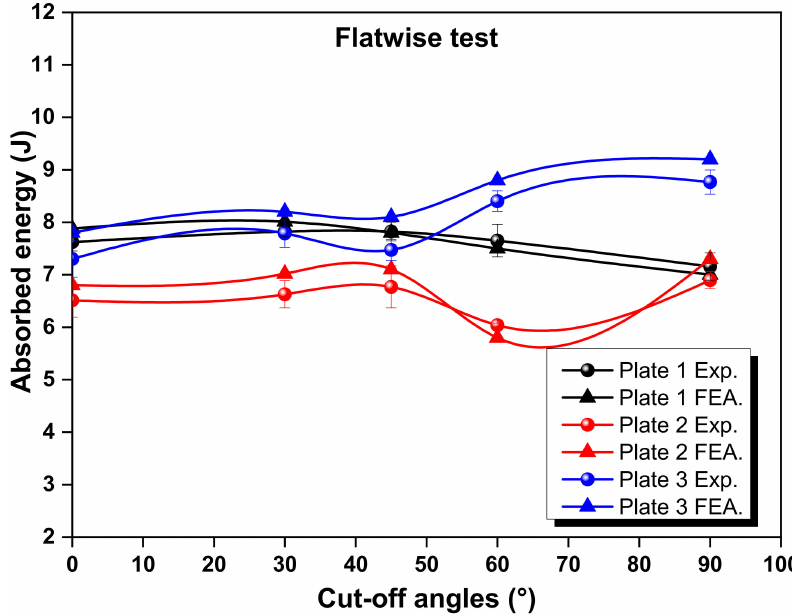
Figure 3. Absorbed energy at various cut-off angles for the flatwise test vs. finite element